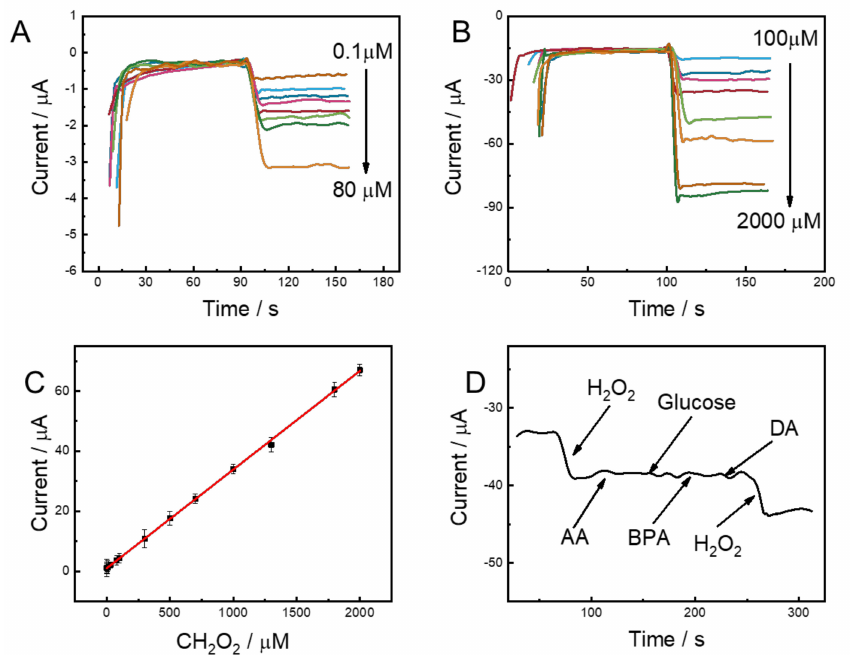
Figure 6. ( A , B ) Amperometric response of PPY-H-BNG/GCE upon the successive addition of H 2 O 2 at low concentrations (from 0.1 to 2000 µ M) into gently stirred 0.1 M KOH; ( C ) calibration curve of the Fe-BC-900/GCE as a function of H 2 O 2 concentration; ( D ) amperometric response of Fe-BC-900/GCE exposed to 0.5 mM H 2 O 2 , 0.5 mM AA, 0.5 mM glucose, 0.1 mM BPA, 0.5 mM DA, and 0.5 mM H 2 O 2